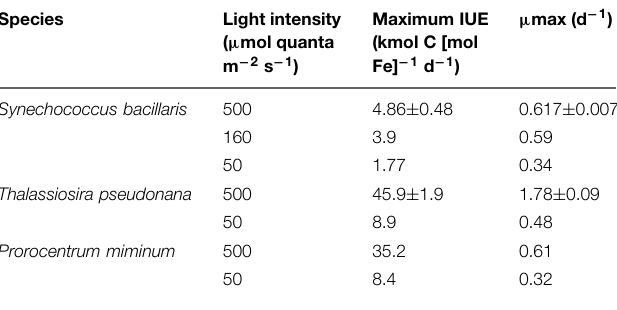
TABLE 1 | Maximum iron use efficiencies (IUE max ) and maximum iron-sufficient growth rates ( µ max ) for Synechococcus bacillaris and two coastal eukaryotic species: the diatom Thalassiosira pseudonana (Sunda and Huntsman, 2011) and the dinoflagellate Prorocentrum minimum (Sunda and Huntsman,